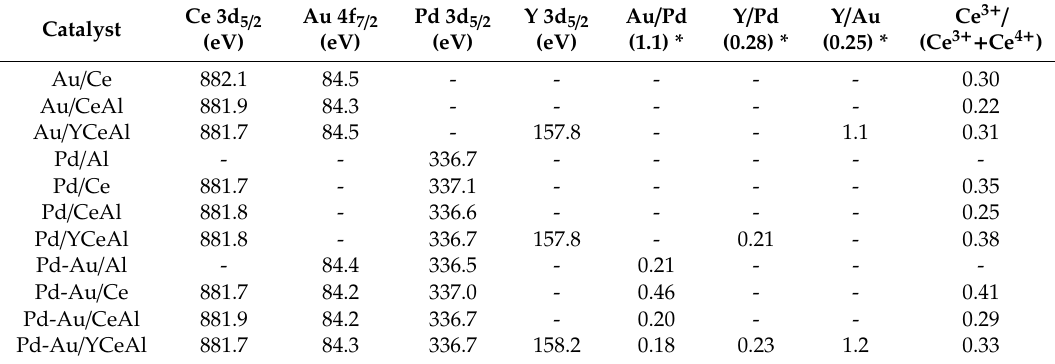
Table 2. X-ray photoelectron spectroscopy (XPS)